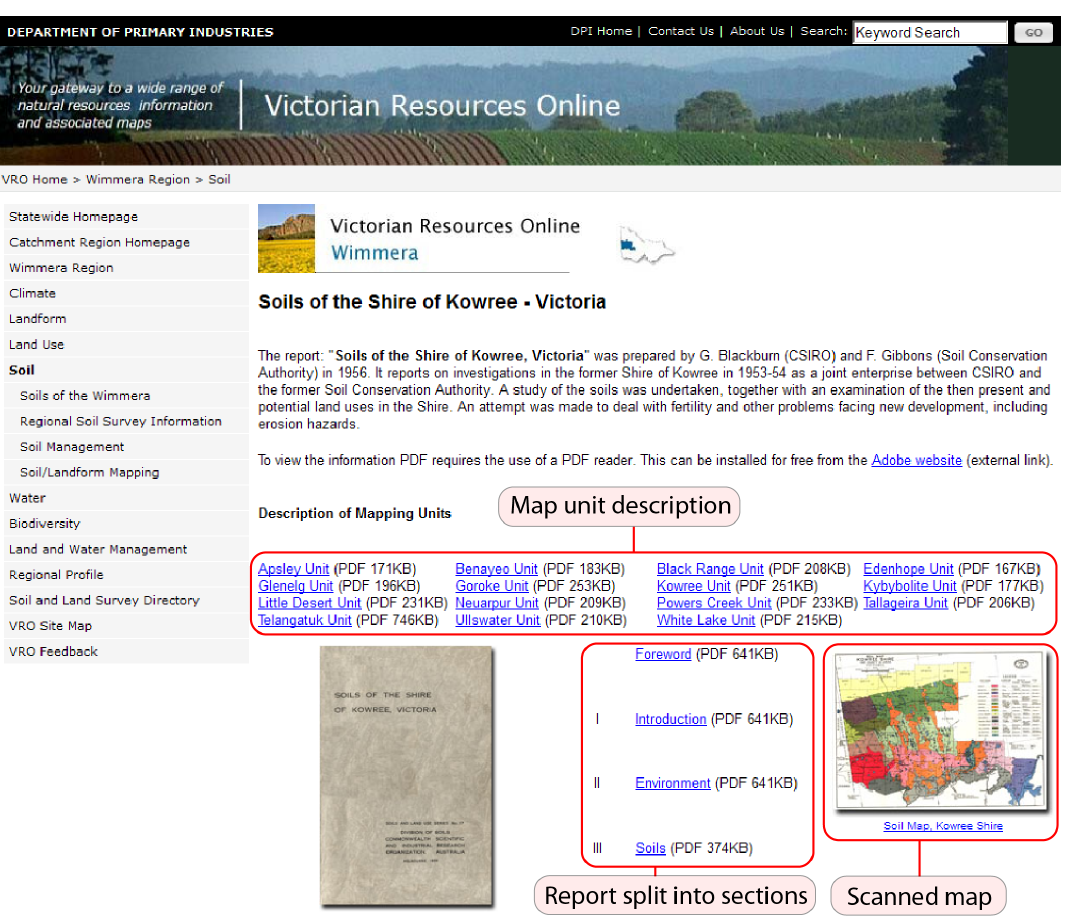
Figure 13. Example legacy report available as a downloadable document on the VRO website.  State of Victoria, Department of Primary Industries 1997 Reproduced with